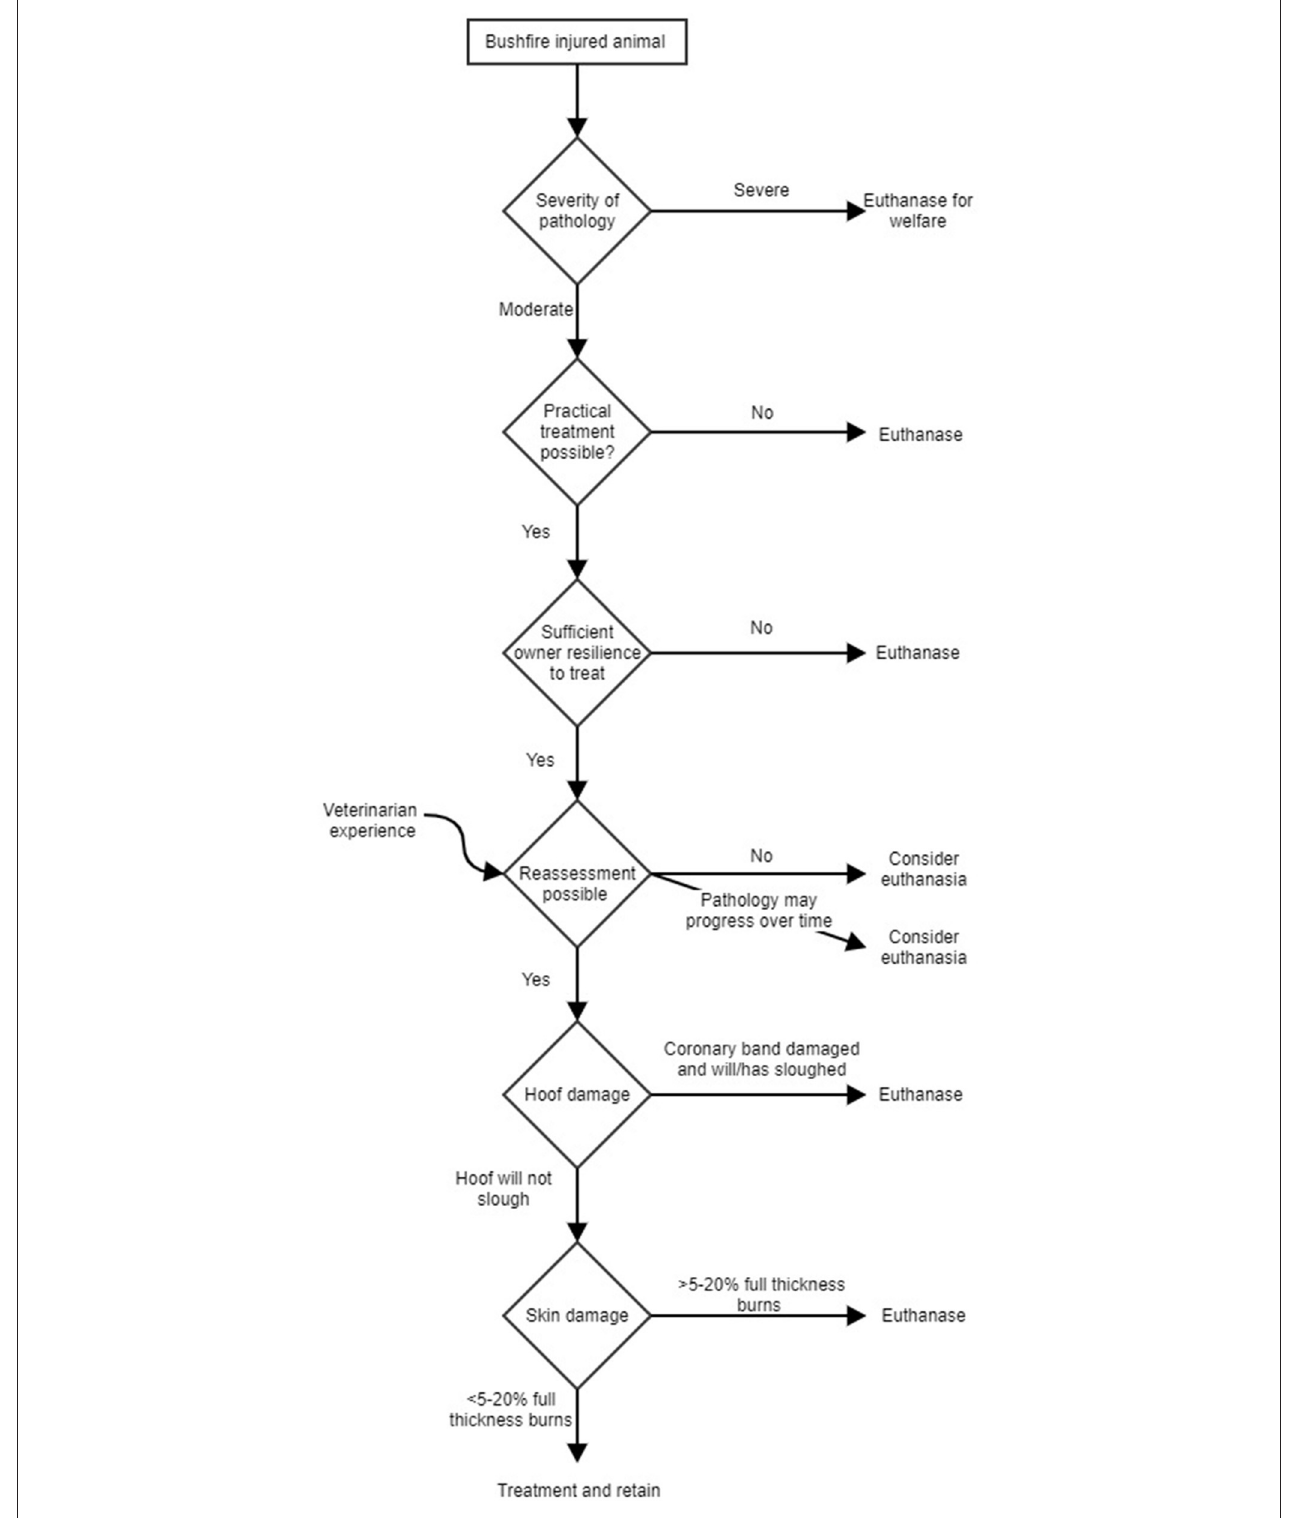
FIGURE 2 | A decision making process for treatment or euthanasia by assessing veterinarians attending moderately or severely bushfire injured livestock.